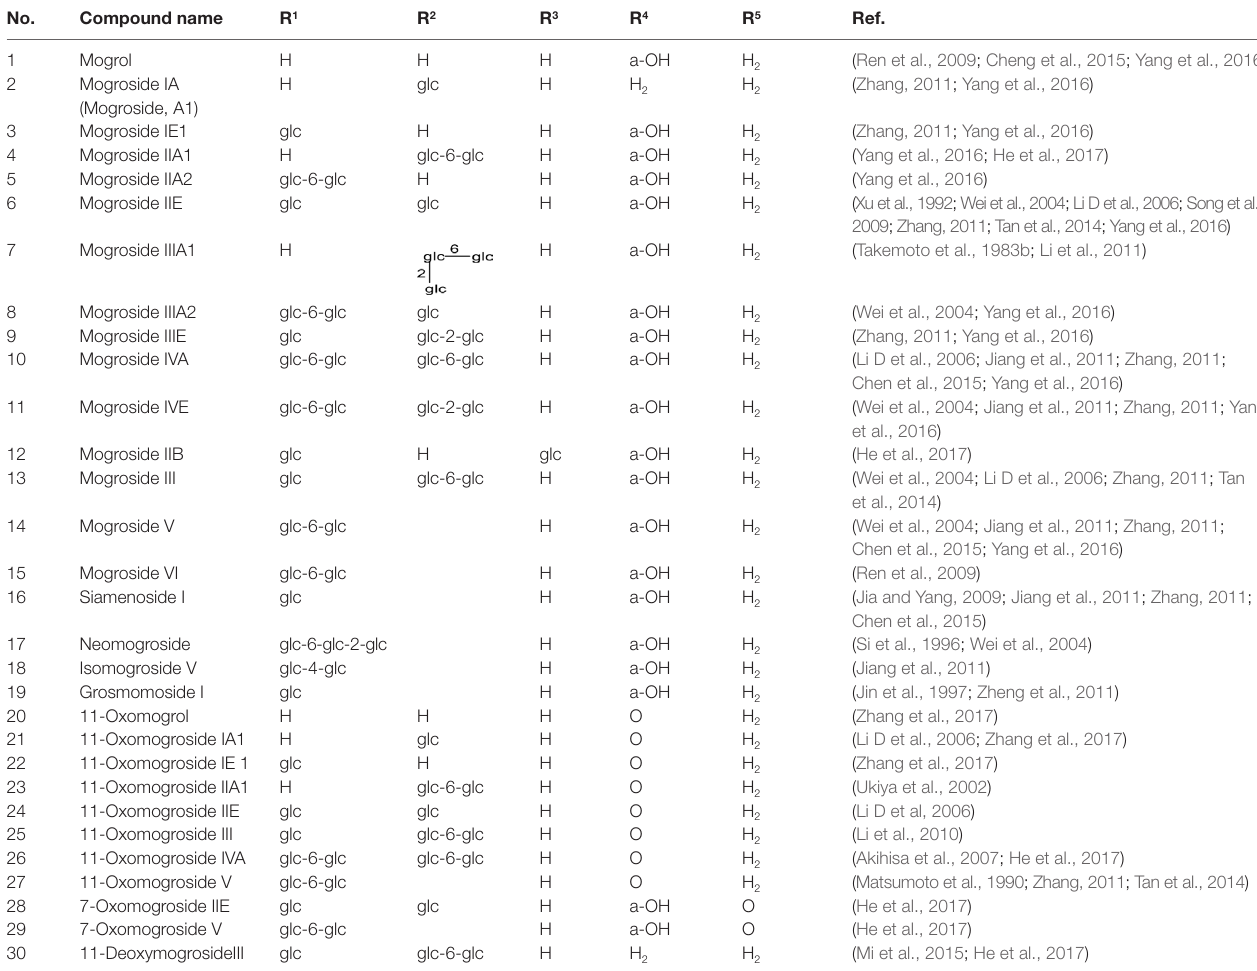
TABLe 3 | Triterpenoid compounds isolated from S. grosvenorii.